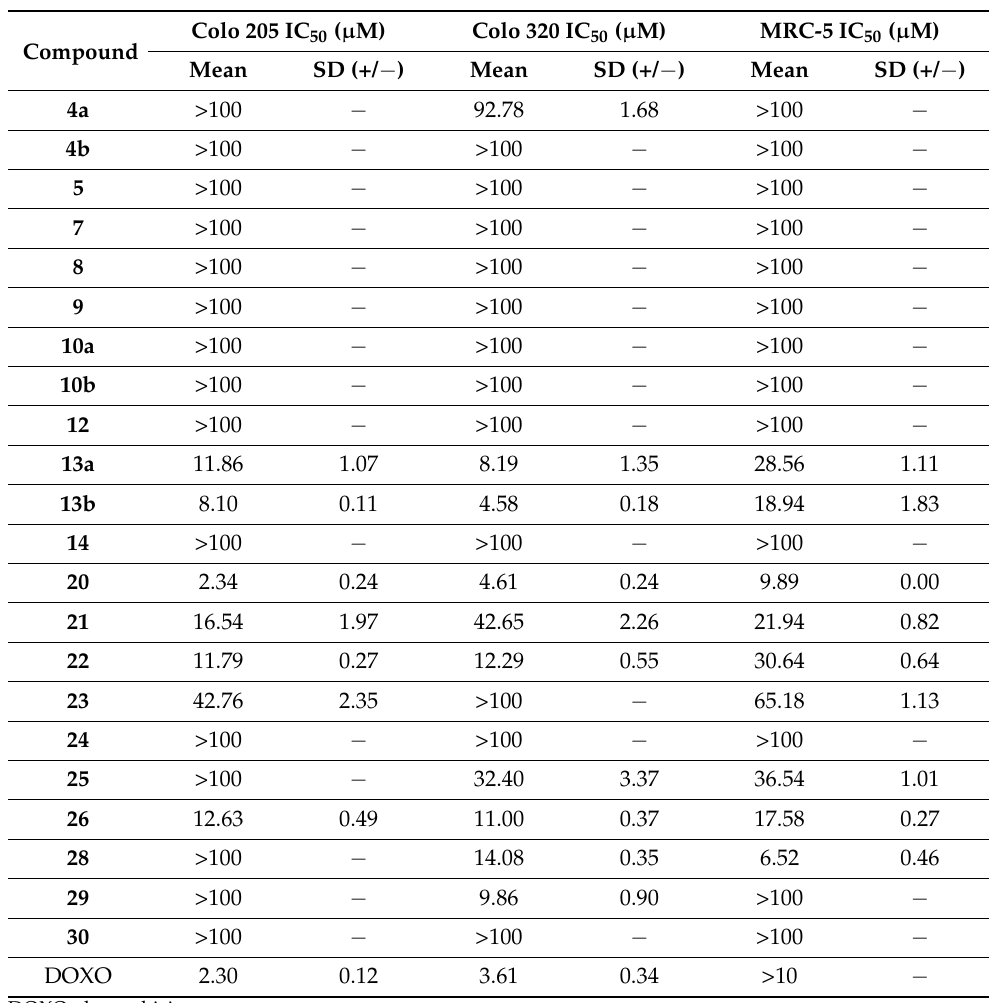
Table 2. Cytotoxic activity of the synthesised compounds on Colo 205 and Colo 320 cell lines, and normal human embryonic MRC-5 fibroblasts.